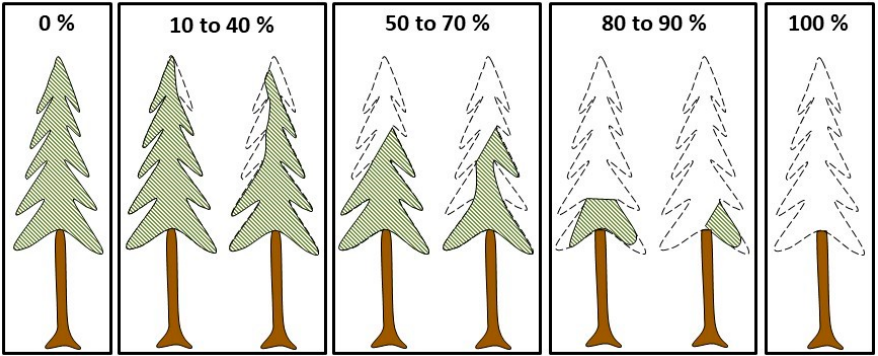
Figure 3. The methodology applied to estimate the level of cumulative defoliation of seedlings and trees. The defoliation scale varies from 0%–100%; green represents healthy or intact foliage, and white represents affected foliage.